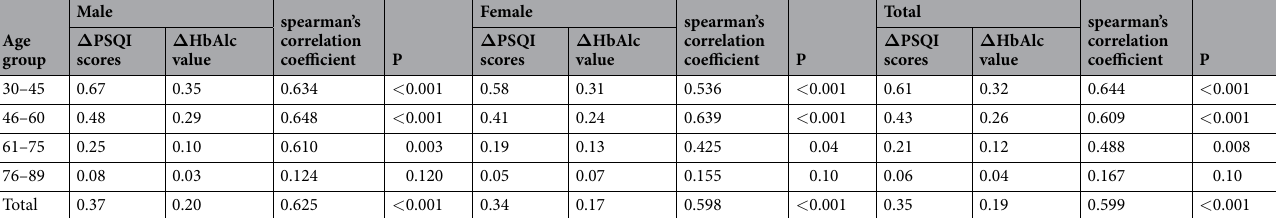
Table 4. Impact of changes from baseline to month 18 in sleep quality on HbAlc according to gender and age. P values were obtained using analysis of the spearman’s correlation analysis.